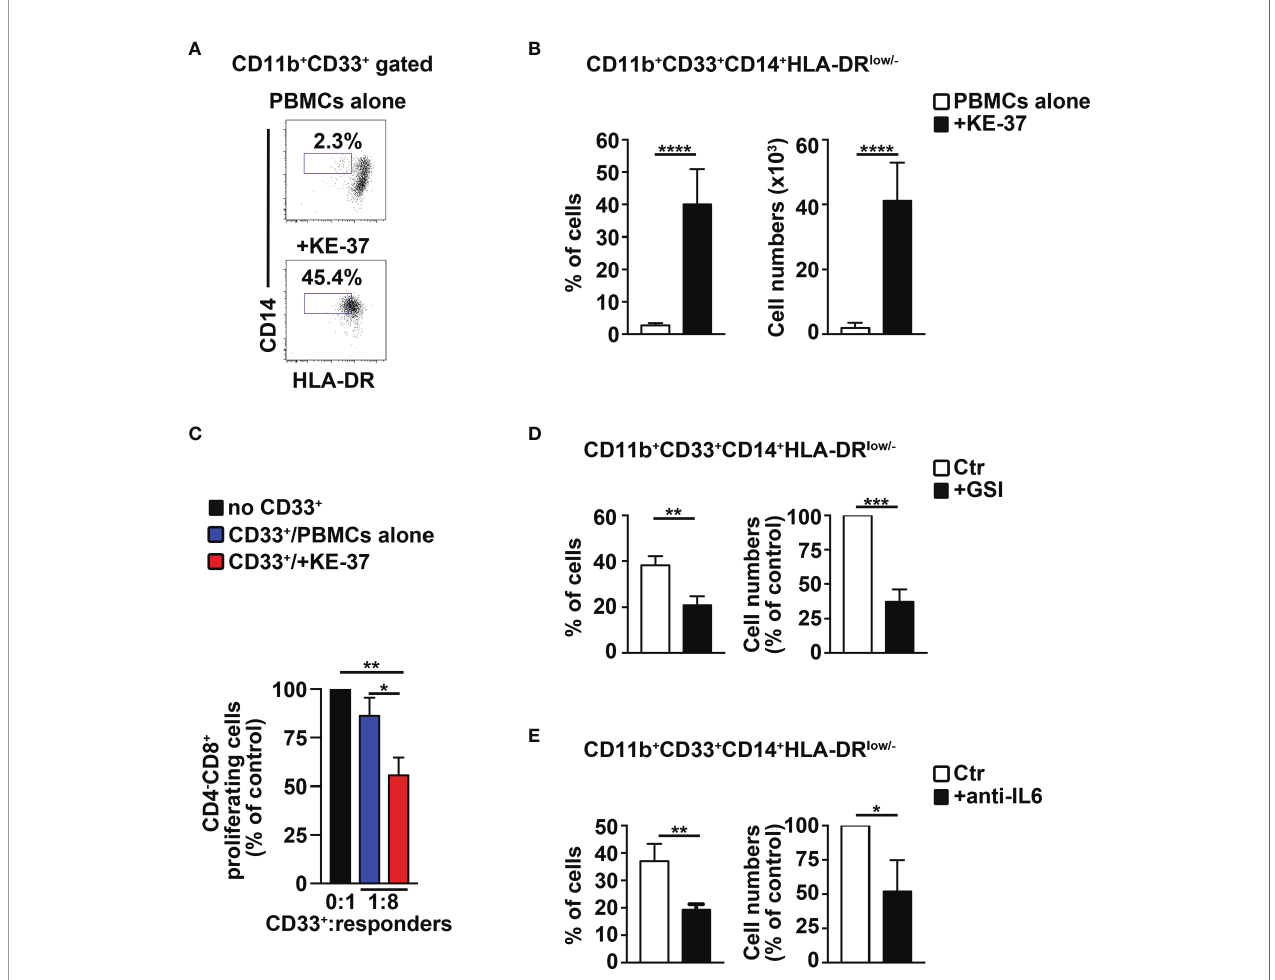
FIGURE 7 | The Notch1-active T-ALL cell line, KE-37 induces MDSCs from healthy PBMCs. PBMCs from healthy donors were cocultured with the human Notch1- dependent T-ALL cell line, KE-37, or were cultured in medium alone, as a control, for 6 days, by using transwell inserts. The data shown are relative to the end of the culture. (A) Representative dot plot of CD14 + HLA-DR low/neg cells inside CD11b + CD33 + subset, as measured by FACS analysis in harvested PBMCs/KE-37 coculture samples (+KE-37), versus samples of autologous PBMCs cultured alone (PBMCs alone). Numbers inside cytograms indicate the percentages of CD11b + CD33 + CD14 + HLA-DR low/neg cells. (B) Percentages and absolute numbers of CD11b + CD33 + CD14 + HLA-DR low/neg cells, measured by the same FACS analysis, as in (A) . The values are presented as mean ± SD from four independent experiments ( n = 6 samples per group, donors n = 6), each in triplicates. (C) At the end of the coculture assay above, CD33 + fractions were magnetically selected from harvested samples and used as “ putative ” suppressors (CD33 + ) in a suppression test on proliferating CD4 − CD8 + -gated cells ( “ responders ” ), from CFSE-labeled/activated autologous PBMCs, at the indicated CD33 + :responder ratios. CD33 + cells were selected from PBMCs cultured either in medium alone (CD33 + /PBMCs alone) or with KE-37 cells (CD33 + /+KE-37). The results are illustrated as the ratio between the percentages of proliferating CD4 − CD8 + -gated cells in cultures containing CD33 + and in control cultures set up in the absence of CD33 + (no CD33 + ) and expressed as % of control. In (D, E) , the graphs report percentages and cell count proportions of CD11b + CD33 + CD14 + HLA-DR low/neg cells in harvested PBMCs/KE-37 cocultures, assessed by the same FACS analysis, as in (A) . The samples in (D) were cultured in the absence (CTR) or presence of GSI (+GSI), and the samples in (E) were cultured in the absence (CTR) or presence of anti-IL-6-neutralizing antibodies (+anti-IL-6). The cell count proportions were calculated as the ratio between the CD11b + CD33 + CD14 + HLA-DR low/neg absolute numbers in PBMCs/KE-37 treated cocultures and in relative untreated controls and expressed as % of control. In (C – E) , the values represent the mean ± SD from three independent experiments ( n = 3 samples per group, donors n = 3), each in triplicates. * p ≤ 0.05, ** p ≤ 0.01, *** p ≤ 0.001, and **** p ≤ 0.0001 represent signi fi cant differences between the indicated